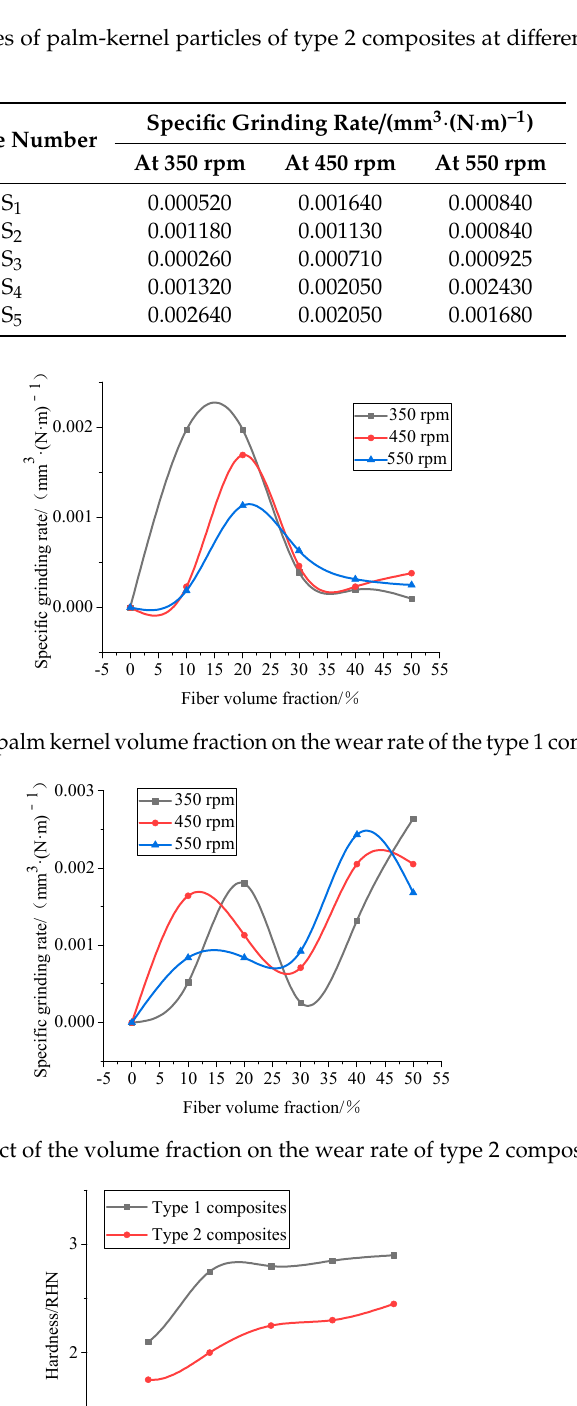
Table 5. Specific wear rates of palm-kernel particles of type 2 composites at different velocities and volume fractions.